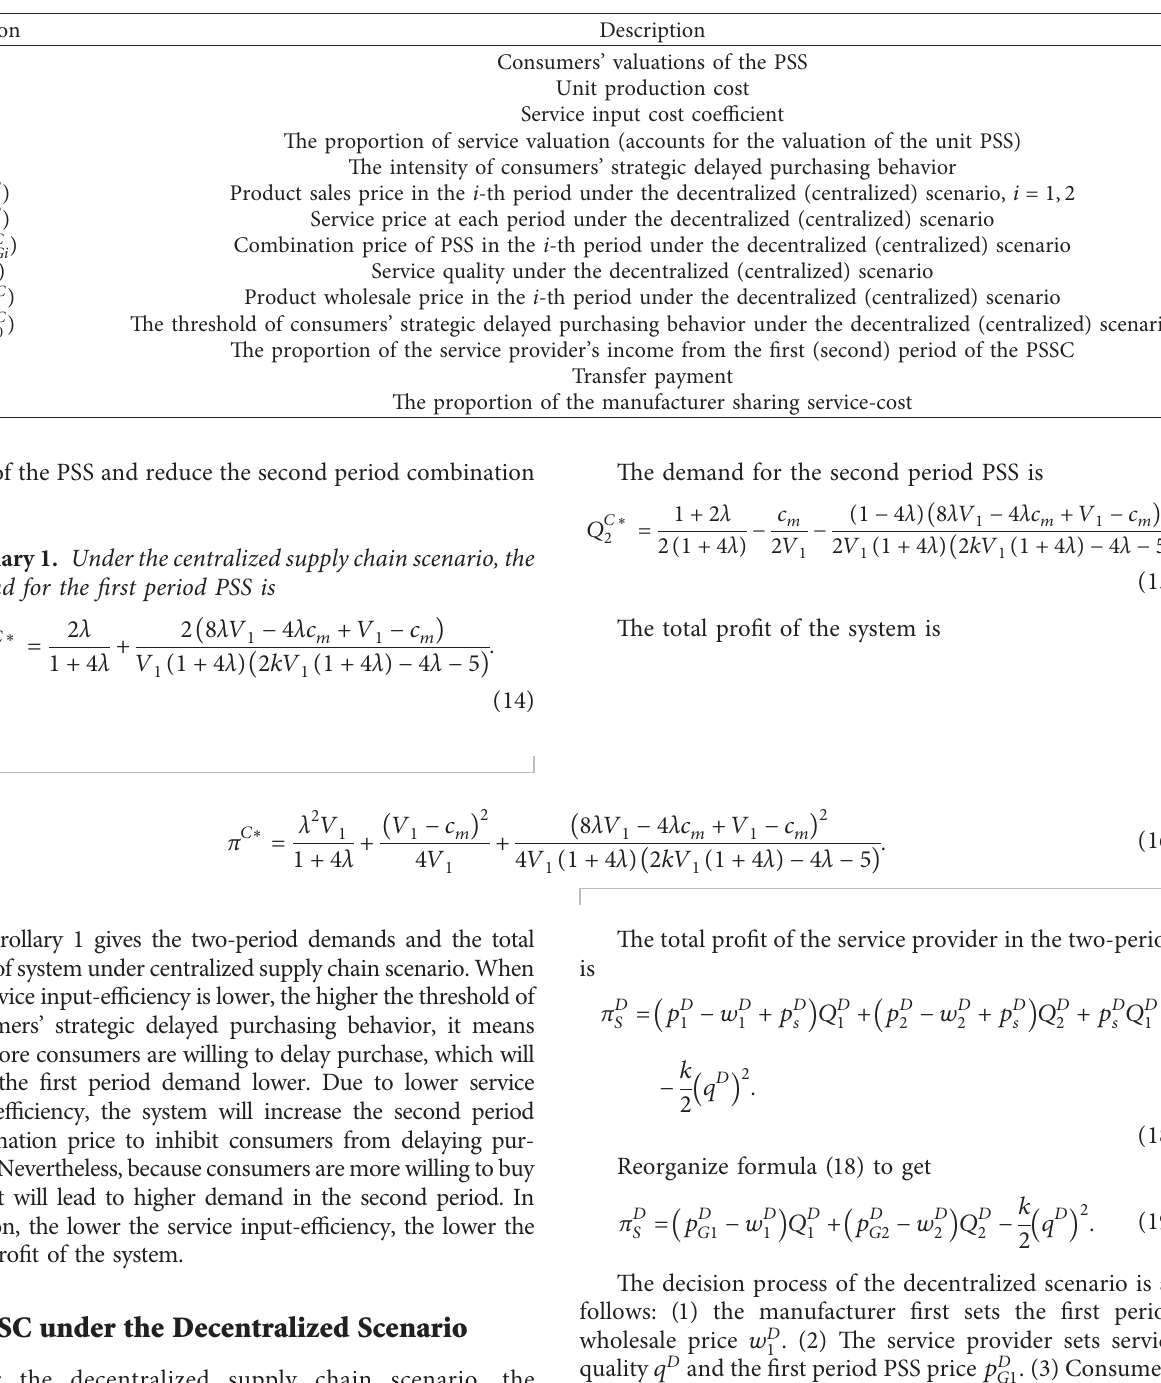
Table 1: Notations for the